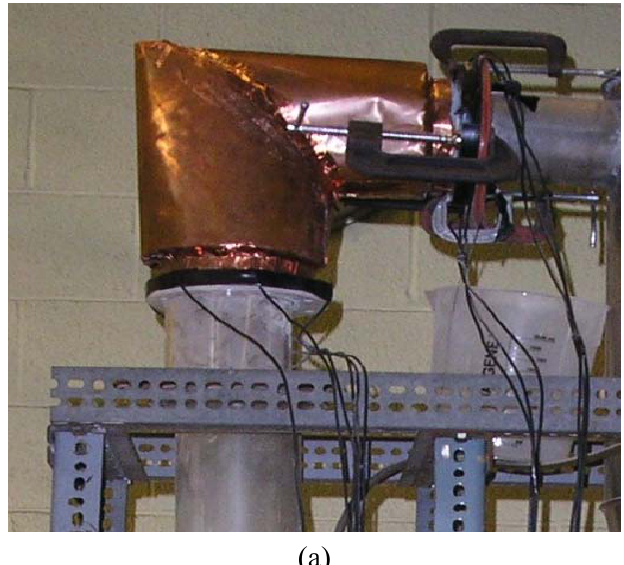
Figure 8. Photos ECVT sensors: (a) right-angle bend sensor; (b) T-junction